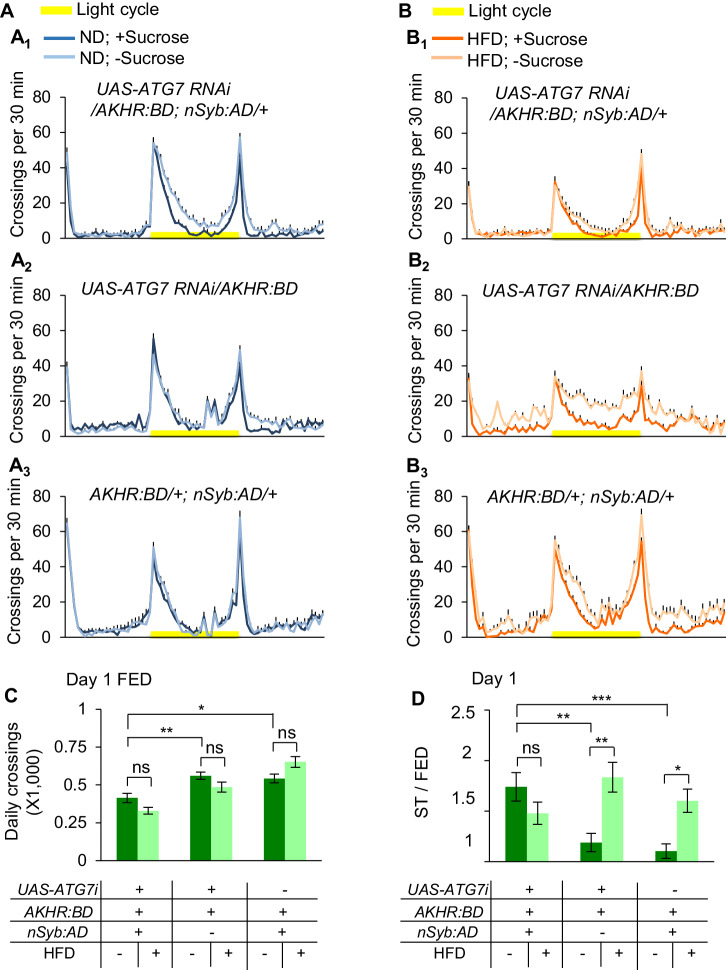
Knocking down ATG7 in AKHR+ neurons promotes starvation-induced hyperactivity.(A–B) Midline crossing activity of indicated genotypes and diet treatments assayed in the presence or absence of 5% sucrose (n = 30–60). (C) Average daily midline crossing activity of fed flies assayed in A-B. (D) Starvation-induced hyperactivity of flies assayed in A-B. ns, p>0.05; *p<0.05; **p<0.01; ****p<0.0001. One-way and two-way ANOVA followed by post hoc test with Bonferroni correction were used for multiple comparisons when applicable.